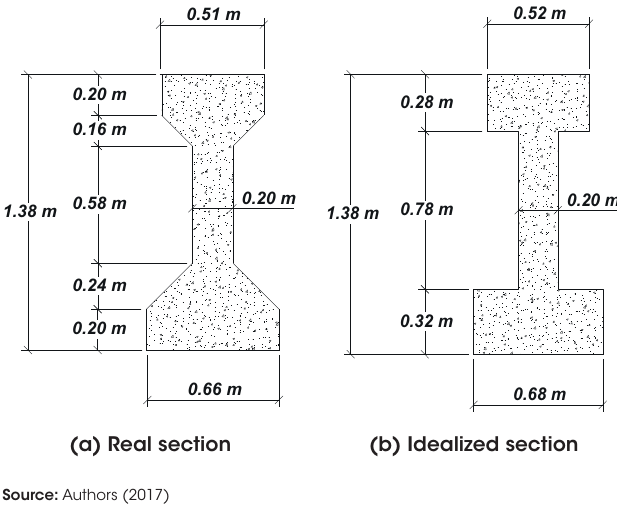
Cross section modified from the AASHTO beam Type IV